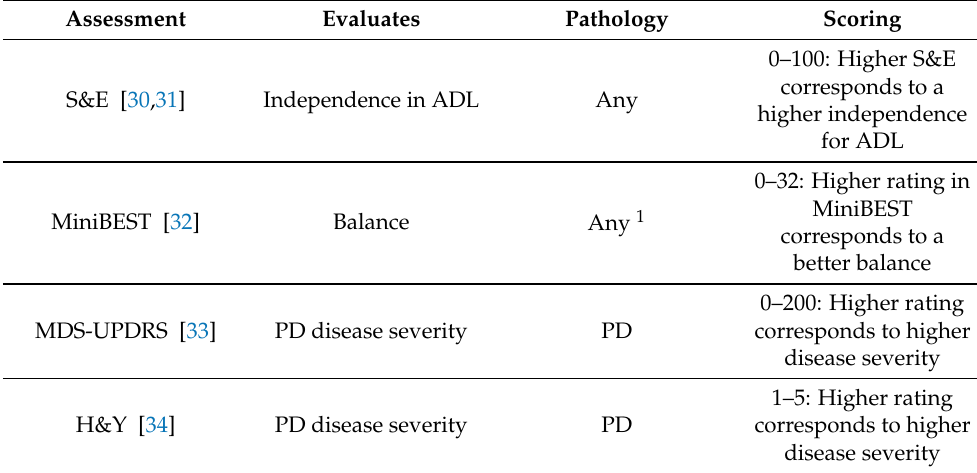
Table 2. Rundown of standardised